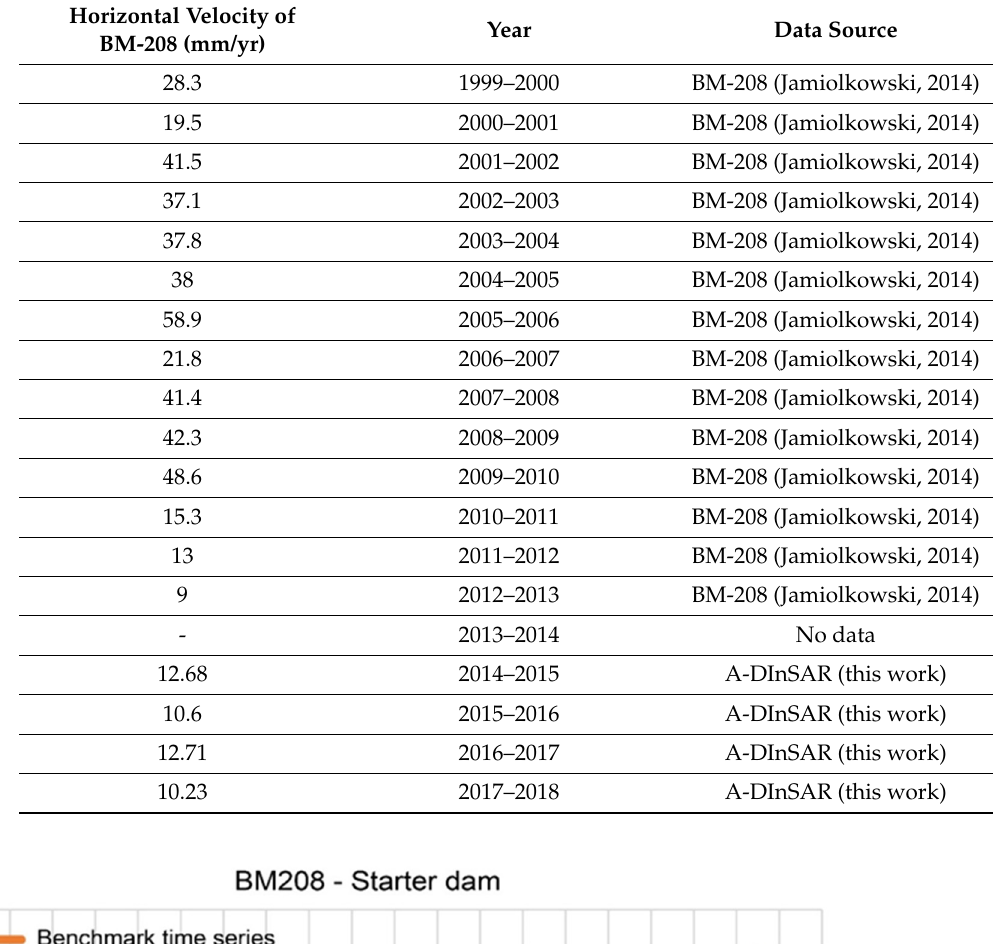
Table 2. Horizontal surface displacement rates of benchmark BM-208 located in the easter sector of the dam; the velocity is an averaged value for each analyzed year.